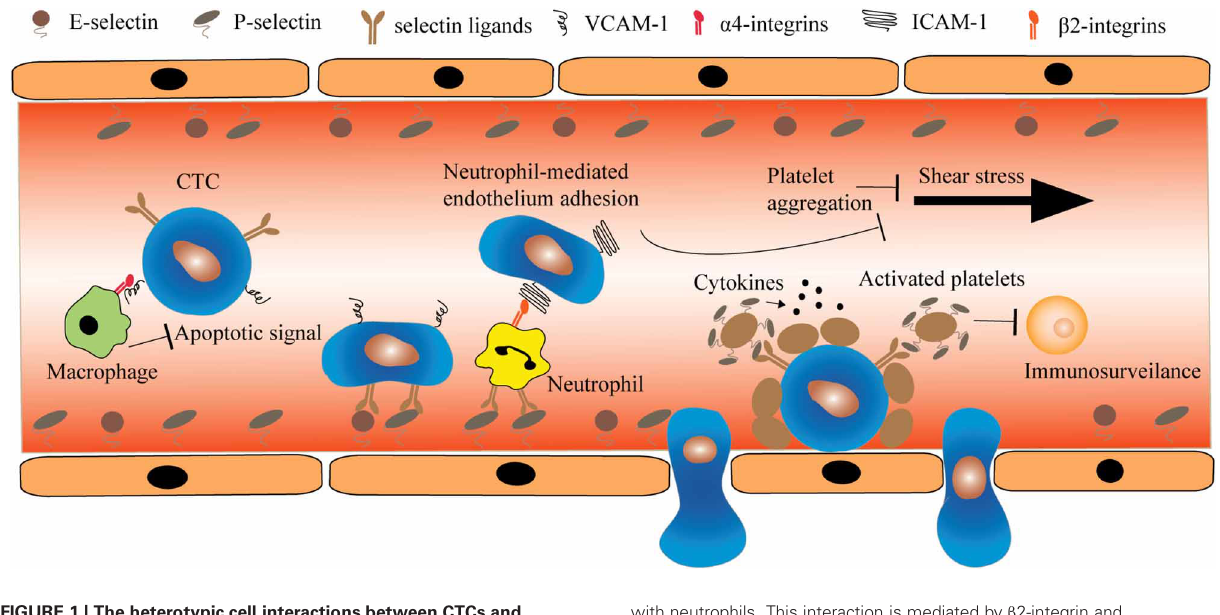
with neutrophils. This interaction is mediated by β 2-integrin and ICAM-1 expressed on neutrophils and CTCs, respectively. Additionally, CTCs can locally induce platelet aggregation. The deposition of platelets on CTCs prevents the damage caused by shear stress and